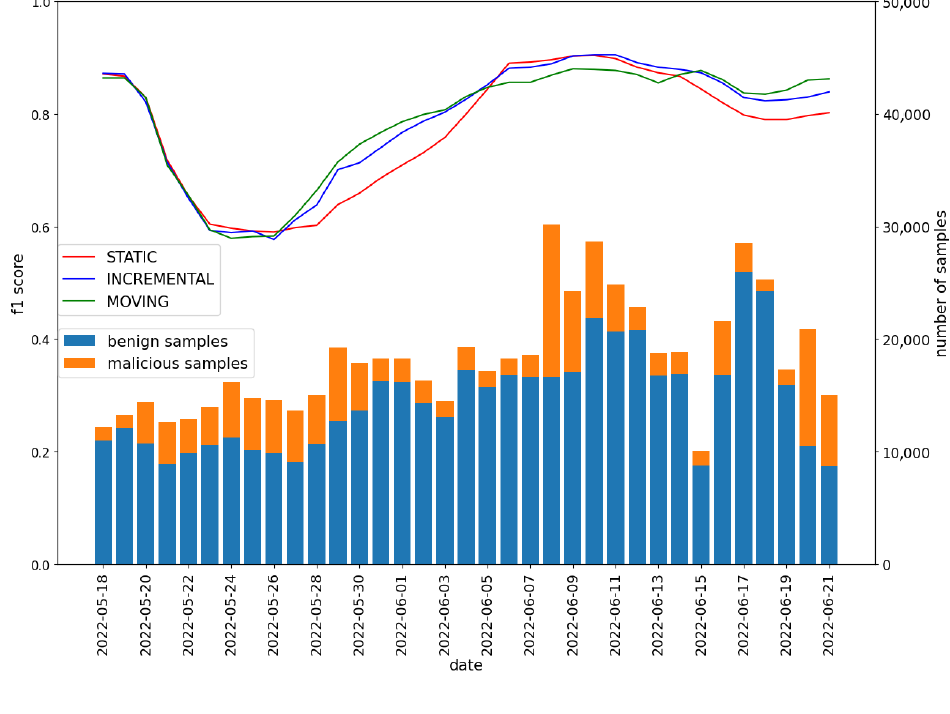
Figure 9. Comparisonof three updating model strategies (left-side axis) and the number of samples on each day of the experiment (right-side axis). Gradient boosting classifier was used to build